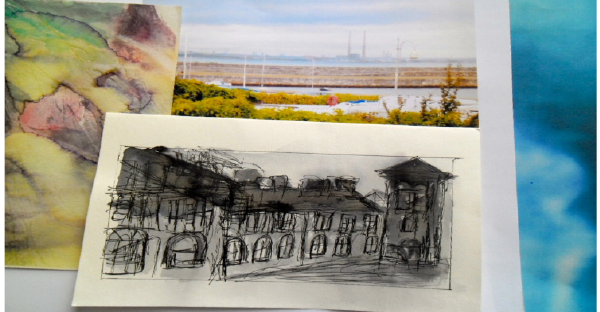
Figure 8. Coast Guard Station fragments, 2015. © Silvia Loeffler, Glas Journal, 2015.